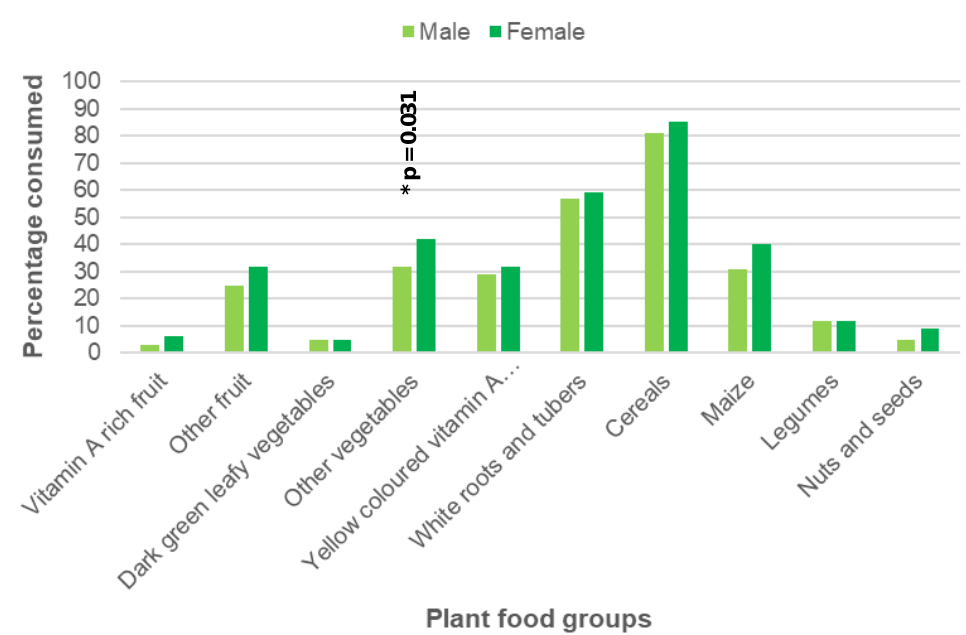
Figure 1. The distribution of plant foods consumption for males and females. The asterisk (*) indicates that the p -value was statistically significant ( p < 0.05).